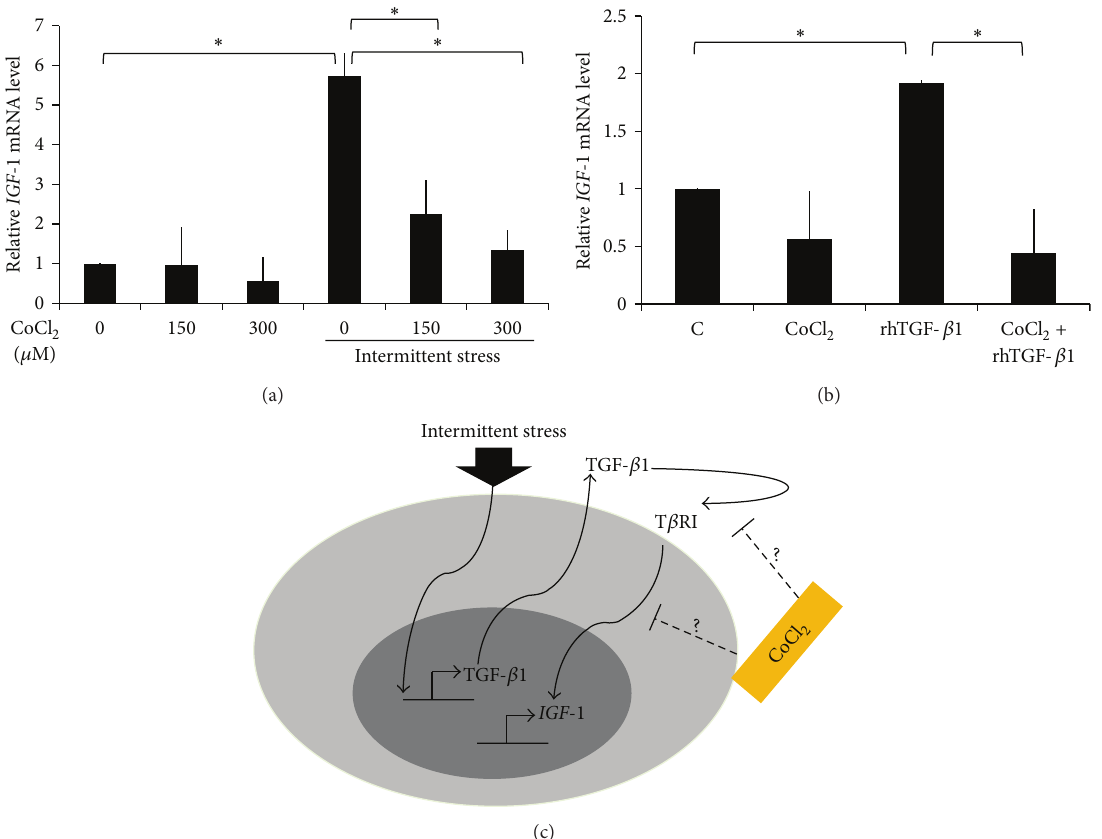
Figure 4: CoCl 2 inhibited the effect of intermittent mechanical stress on IGF-1 expression. (a) HPDLs were treated with CoCl 2 (150 and 300 𝜇 M) in the presence or absence of intermittent mechanical stress stimulation for 24h. The IGF-1 expression was evaluated by real-time PCR. (b) IGF-1 expression was examined after HPDLs were treated with rhTGF- 𝛽 1 (2ng/mL) with and without the CoCl 2 (150 𝜇 M) for 24 h. (c) The illustration represented the proposed signaling mechanism of the intermittent mechanical stress-induced IGF-1 expression by HPDLs. Asterisks indicated statistically significant difference. C: the control condition; S: the intermittent mechanical stress treatment